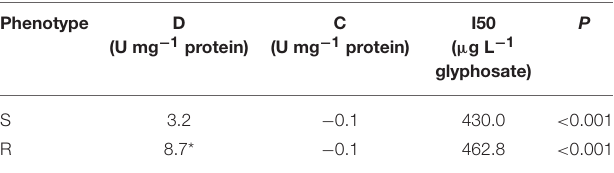
TABLE 2 | Non-linear regression parameters for the activity of EPSPS from glyphosate-susceptible (S) and -resistant (R) phenotypes and P- values for model accuracy.